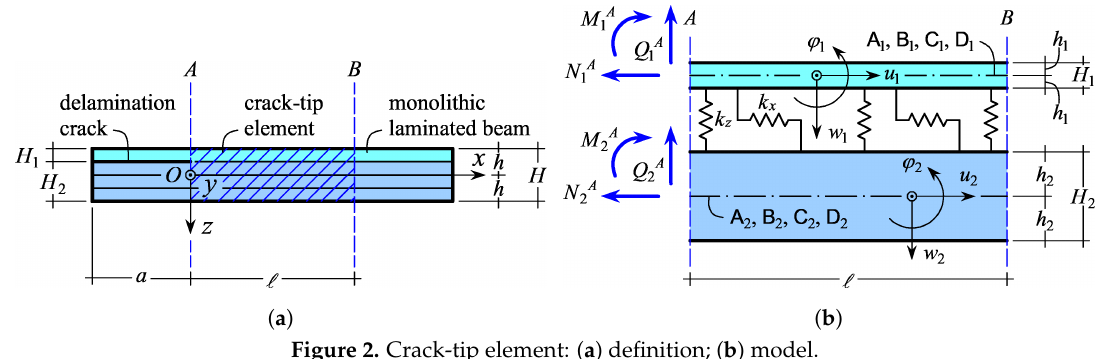
Figure 2. Crack-tip element: ( a ) definition; ( b )